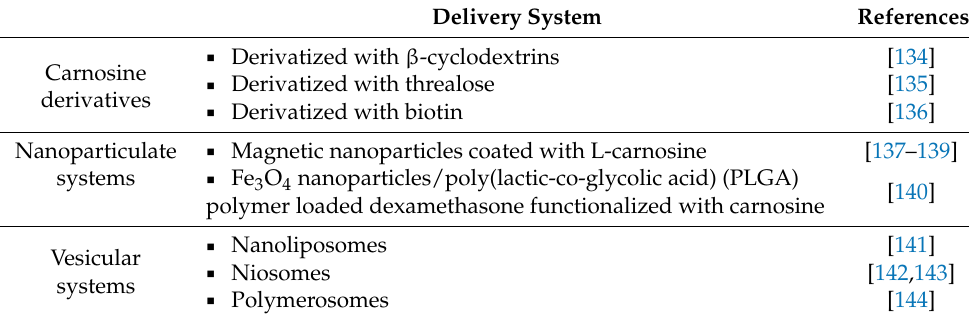
Table 1. List of drug delivery strategies for carnosine.